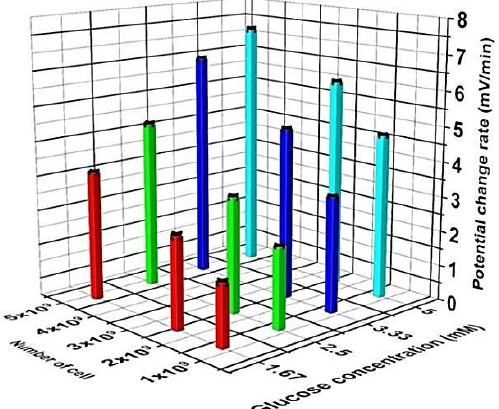
Figure 3. 3D plot of mean values and standard deviations (three repetitions) of the potential change rates for four successive independent measurements with different glucose concentrations (1.67, 2.5, 3.33, 5 mM) when varying the cell numbers (1.2 × 10 9 , 2.4 × 10 9 , 4.8 × 10 9 cells) in 200 µ L of L. brevis cell suspension. Data are calculated from Figure 2. Mean values and standard deviations of PCR values were obtained from three independent measurement repetitions within the first 6 min after adding cells. For each chamber, four laser-diode modules (LDMs) were used. The mean value of signals per chamber was considered for further